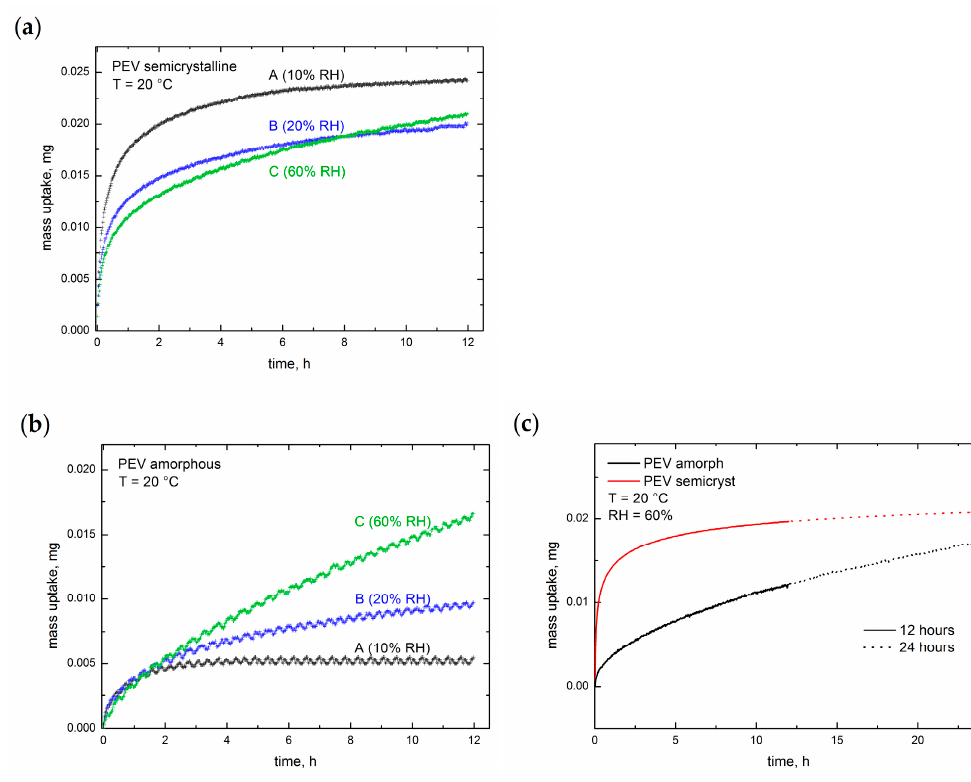
Figure 4. ( a ) Water vapor sorption kinetic of amorphous and ( b ) semicrystalline PEV at 20 ◦ C and different relative humidity (10%, 20%, 60%). The time step is maintained constant at 12 h. ( c ) Water vapor sorption kinetic of amorphous and semicrystalline PEV at 20 ◦ C and RH 60% for increasing the time step: 12 and 24 h .